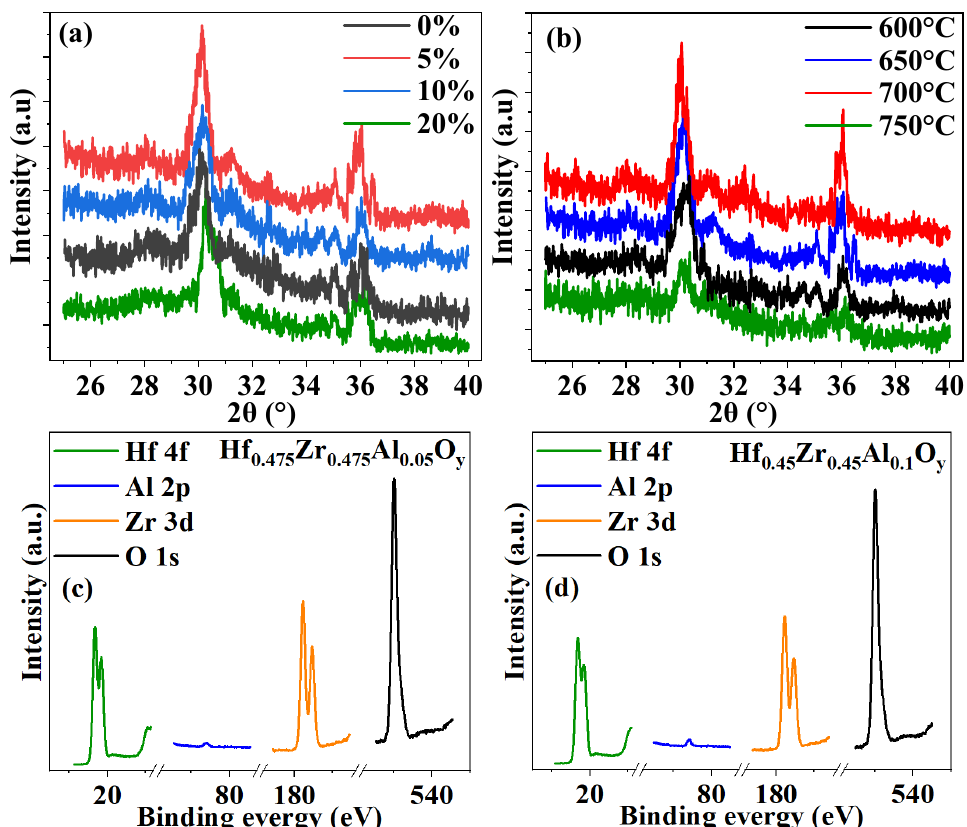
Figure 6. XRD patterns of ( a ) HZAO thin films with different Al contents and ( b ) Hf 0.475 Zr 0.475 Al 0.05 O y thin films annealed at 600 °C, 650 °C, 700 °C and 750 °C, respectively; Hf 4f, Zr 3d, Al 3p and Q 1s XPS spectra of ( c ) Hf 0.475 Zr 0.475 Al 0.05 O y thin film and ( d ) Hf 0.45 Zr 0.45 Al 0.1 O y thin film.